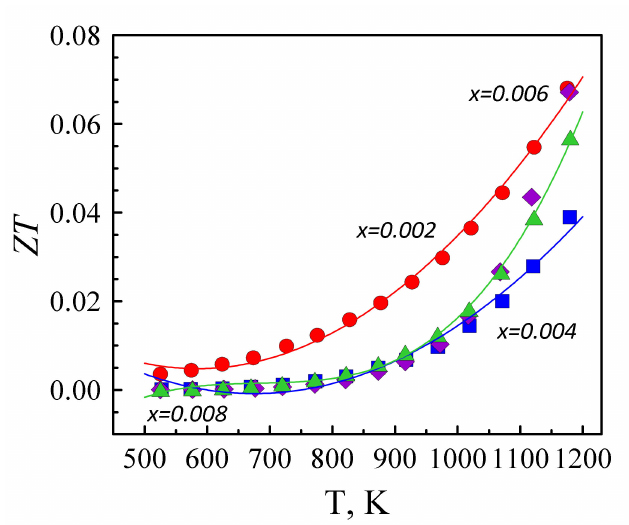
Figure 8. Temperature dependence of the dimensionless